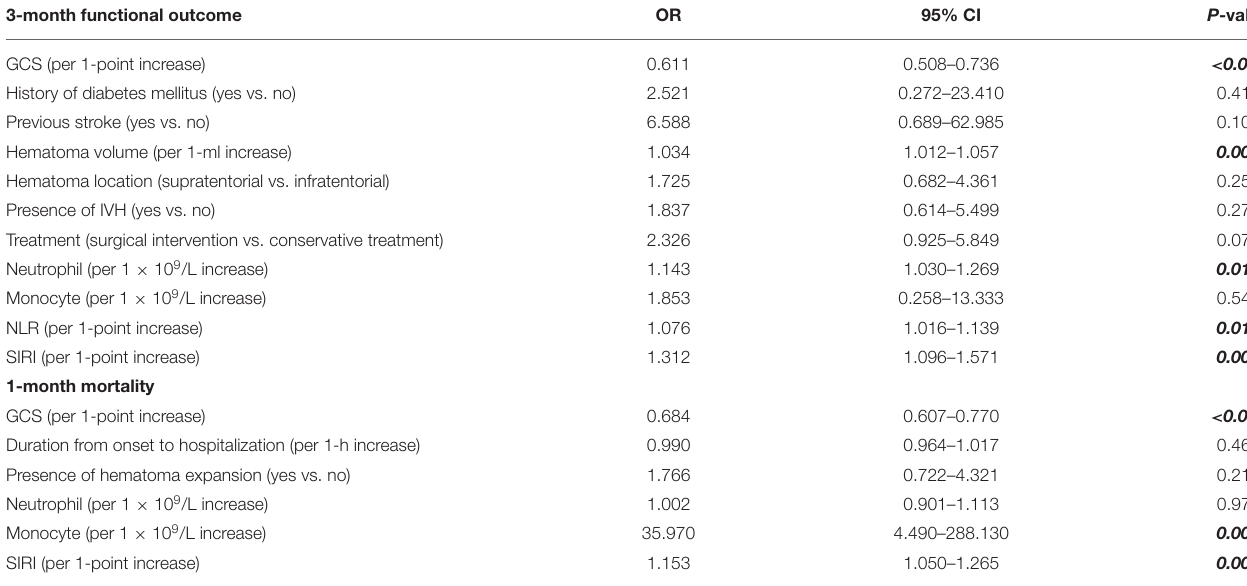
TABLE 4 | Multivariate logistic regression of included clinical variables for 3-month functional outcome and 1-month mortality in PSM